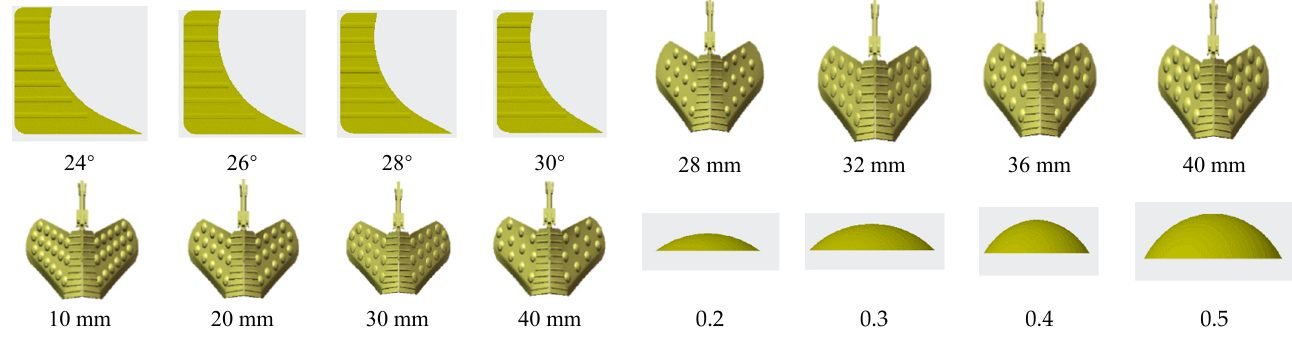
Figure 4. The textured shovel wing models with different structural